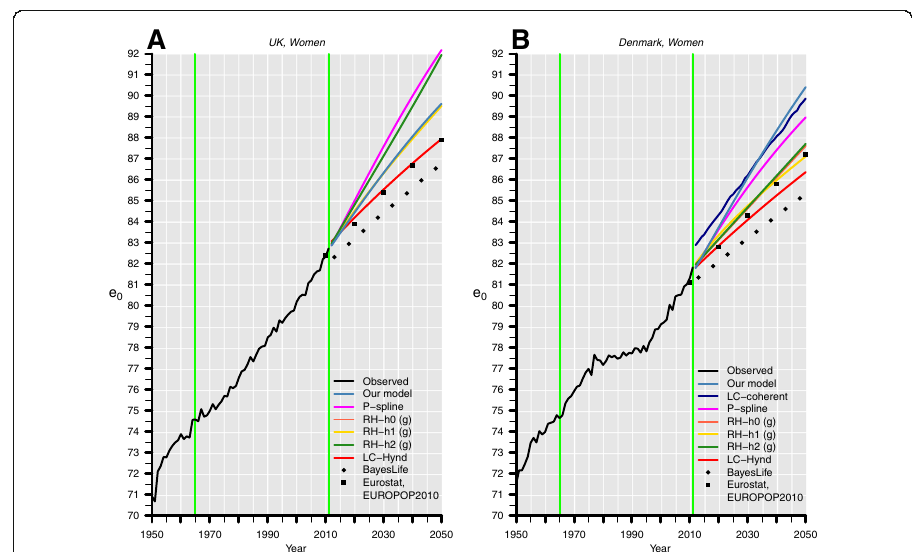
Fig. 5 Observed ( black line ) and forecasted life expectancy at birth ( e 0 ) of our model ( blue ), the P-spline approach ( magenta ), the LC model ( red ), four of its variants — h0 ( light red ), h1 ( yellow ), h2 ( green ), and coherent ( navy blue ) — the UN Bayesian approach ( triangles ), and of Eurostat ( squares ) for women in the UK ( left ) and Denmark ( right ). The forecasts from 2012 to 2050 rely on data from 1965 to 2011 ( green vertical lines ). We combine mortality trends of Danish, Swedish, French, Italian, and Japanese women in our model as well as in the coherent LC model. In the RH models, (p) and (g) denote Poisson and Gaussian errors,